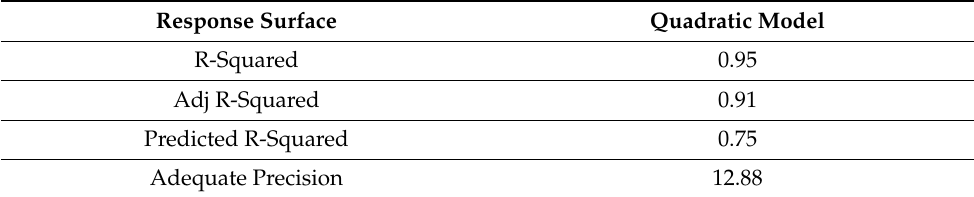
Table 5. Summary of ANOVA and regression analysis of oil contact